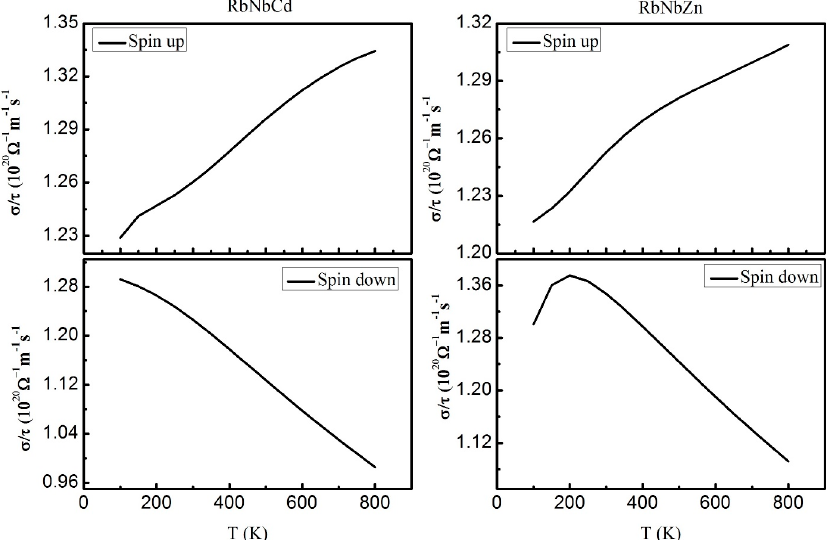
Figure 12. Temperature dependence of the conductivity integral ( σ / τ ) for RbNbCd and RbNbZn.